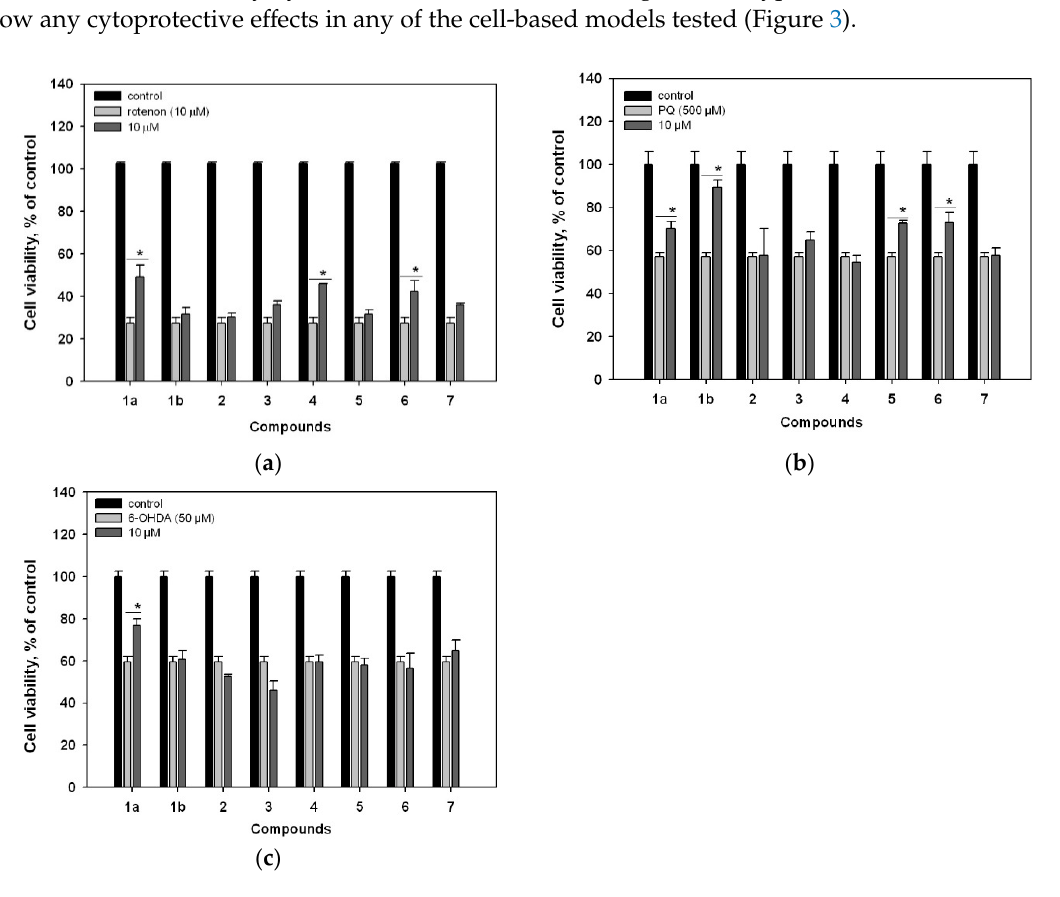
Figure 3. Effects of compounds 1 – 7 on the viability of Neuro-2a cells treated with rotenone ( a ), PQ ( b ), and 6-OHDA ( c ). Cells were pretreated with 10 µM of the tested compound ( 1 – 7 ) for 1 h,